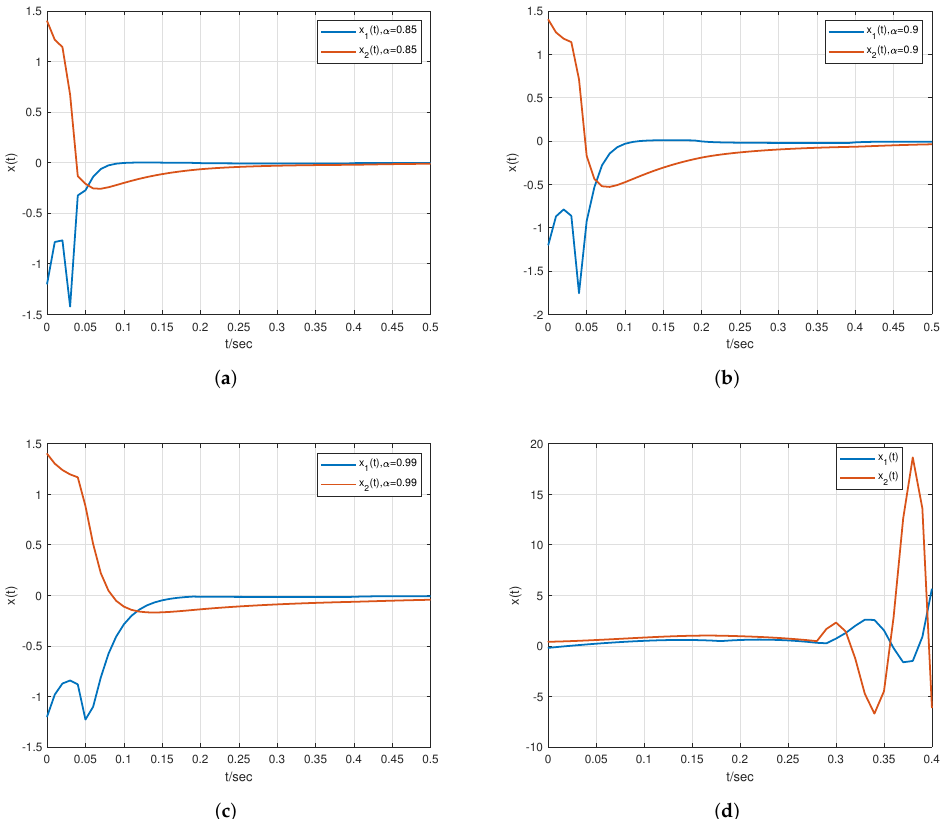
Figure 2. The panels ( a – c ) contain the trajectories of the state variable x 1 ( t ) and x 2 ( t ) for L 2 − L ∞ performance with distinct FO circumstances α = 0.85,0.9,0.99. Moreover, panel ( d ) is the trajectories of the open loop system in Example 1.